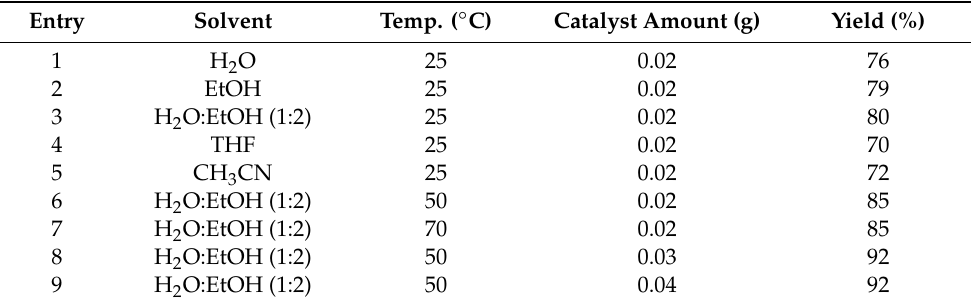
Table 2. Optimization of reaction condition for the synthesis of model xanthene.